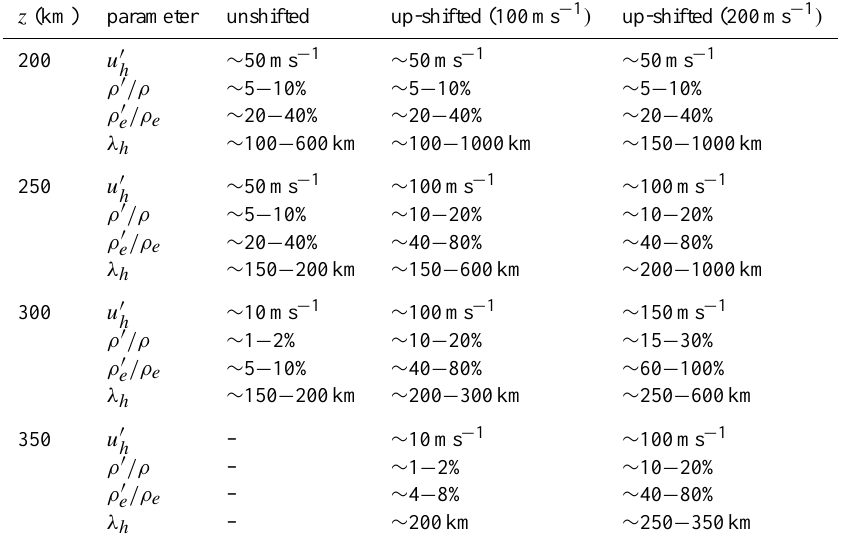
Table 4. Approximate GW horizontal velocity, neutral and electron density perturbations, and horizontal wavelength ranges for mean solar conditions, ( ρ 0 e /ρ e ) /( ρ 0 / ρ) ∼ 4, and unshifted (left column), up-shifted with a 100ms − 1 mean wind (center column), and up-shifted with